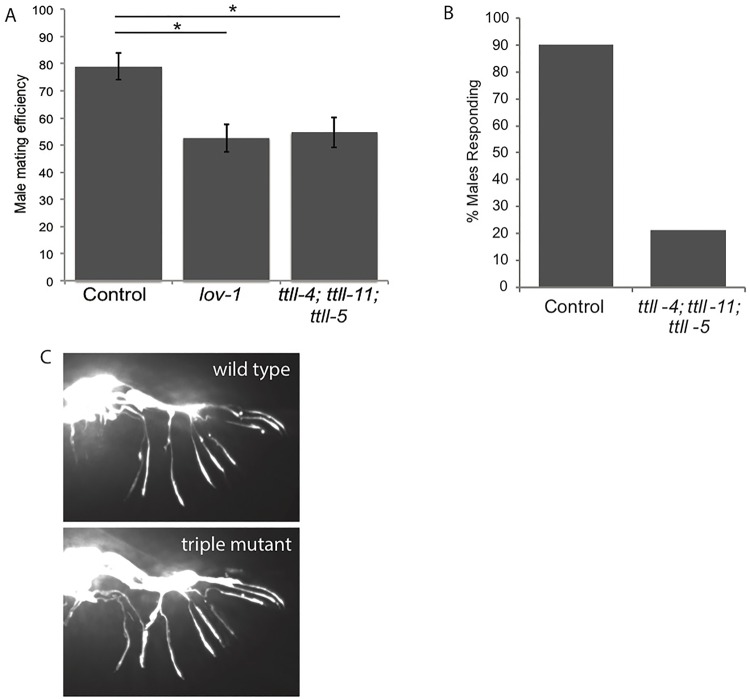
Triple mutants show male-mating defects. (A) Male mating efficiency is reduced in the triple mutant. lov-1(sy552) was used as a positive control. Error bars indicate s.e.m. *P<0.01, Student's t-test. (B) Triple mutant males show a defect in the response step of male mating. Wild type n=51 worms; ttll-4;ttll-11; ttll-5 n=61 worms. (C) pkd-2p::GFP reveals the structure of the male-specific neurons of the male ray in wild type and ttll-4(tm3310); ttll-11(tm4059);
ttll-5(tm3360) triple mutant worms. Small differences in neuron crossing are not significant.